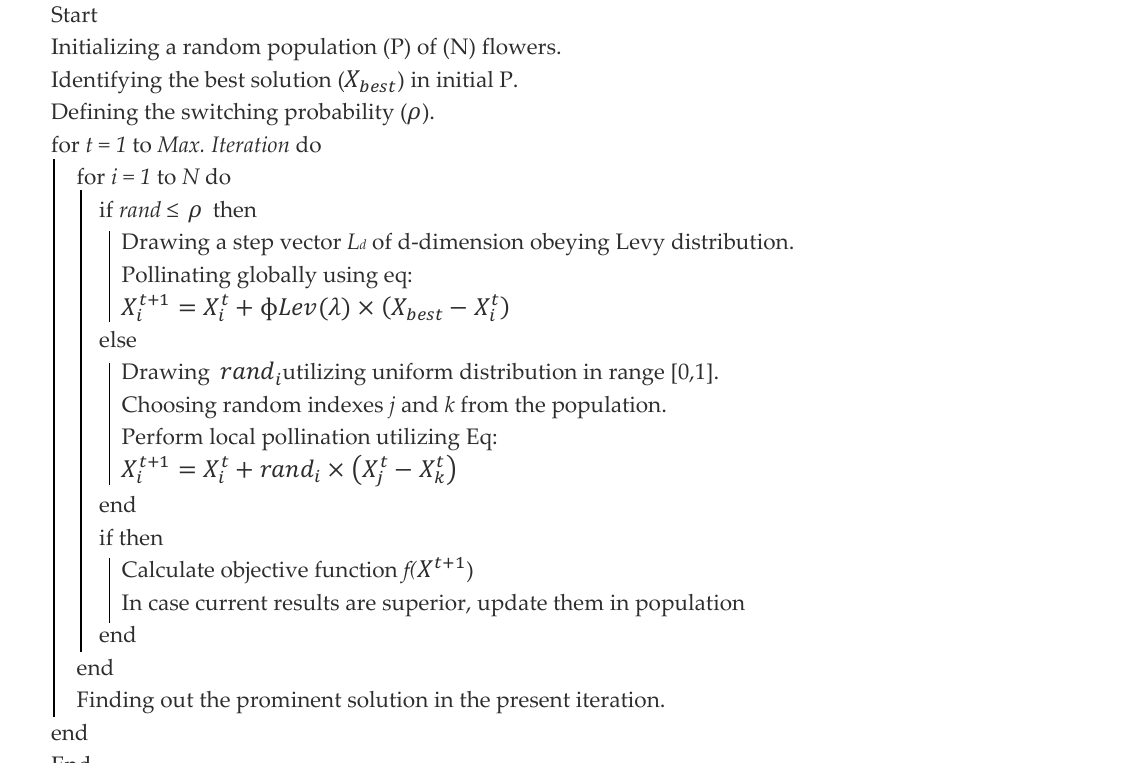
Algorithm 1 : Multi-objective flower pollination algorithm (MOFPA) pseudo code